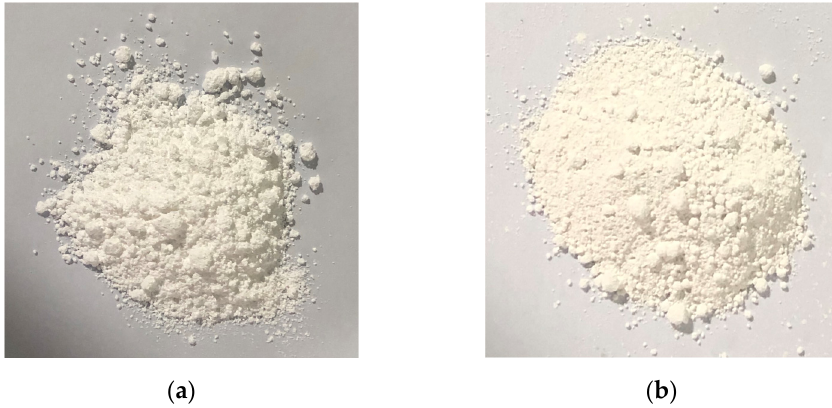
Figure 2. Transparent soil test materials ( a ) U10 and ( b ) Titanium oxide.